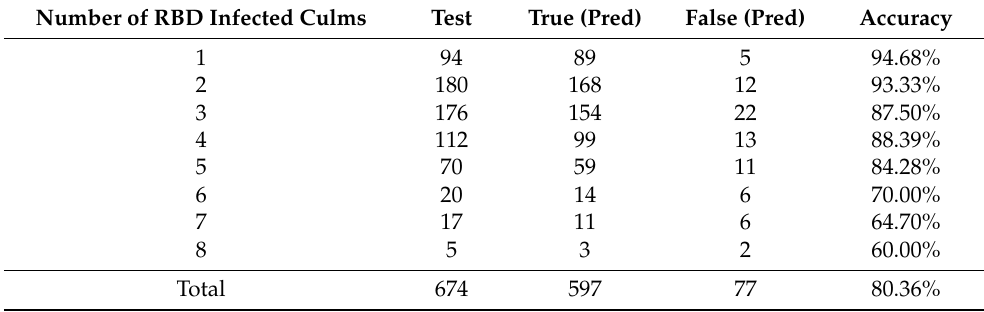
Table 9. The number of culm classification performance results for 50 layers of deep residual